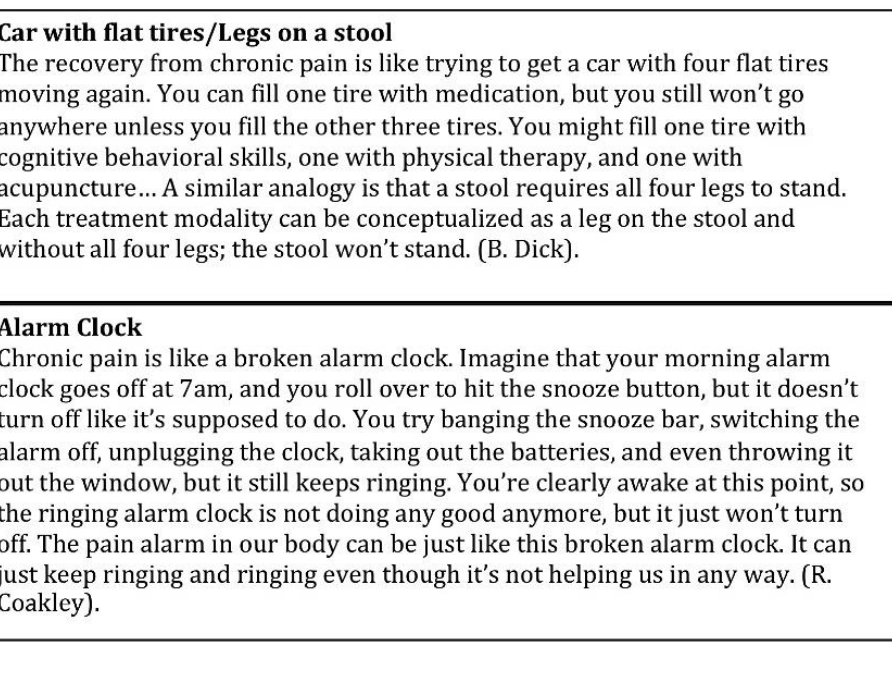
Figure 6. Example metaphors for explaining chronic pain to children. Adapted from Coakley,